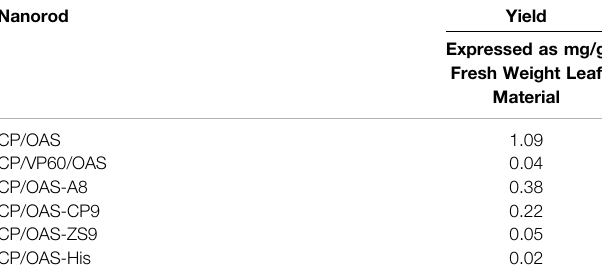
TABLE 1 | Yield of nanorods.